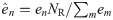
Global inhibition with thresholding leads to sparse odor representations a.(A) Excitations en for an arbitrary odor. Active channels (orange) have an excitation above the threshold (red line, inhibition strength α = 1.4). The right axis indicates the normalized excitation e^n=enNR/∑mem. (B) Histogram of the number of active channels compared to a binomial distribution (black line) with the same mean for α = 1.4. (C) Mean channel activity 〈an〉 as a function of α. The approximation given by Eq (6) (solid line) is compared to numerical simulations (symbols, standard error of the mean smaller than symbol size). The gray dotted line indicates a single expected active channel in humans, 〈an〉=1300. (A–C) Additional model parameters are NR = 32, NL = 256, pi = 0.1, μi = σi = 1, and λ = 1.